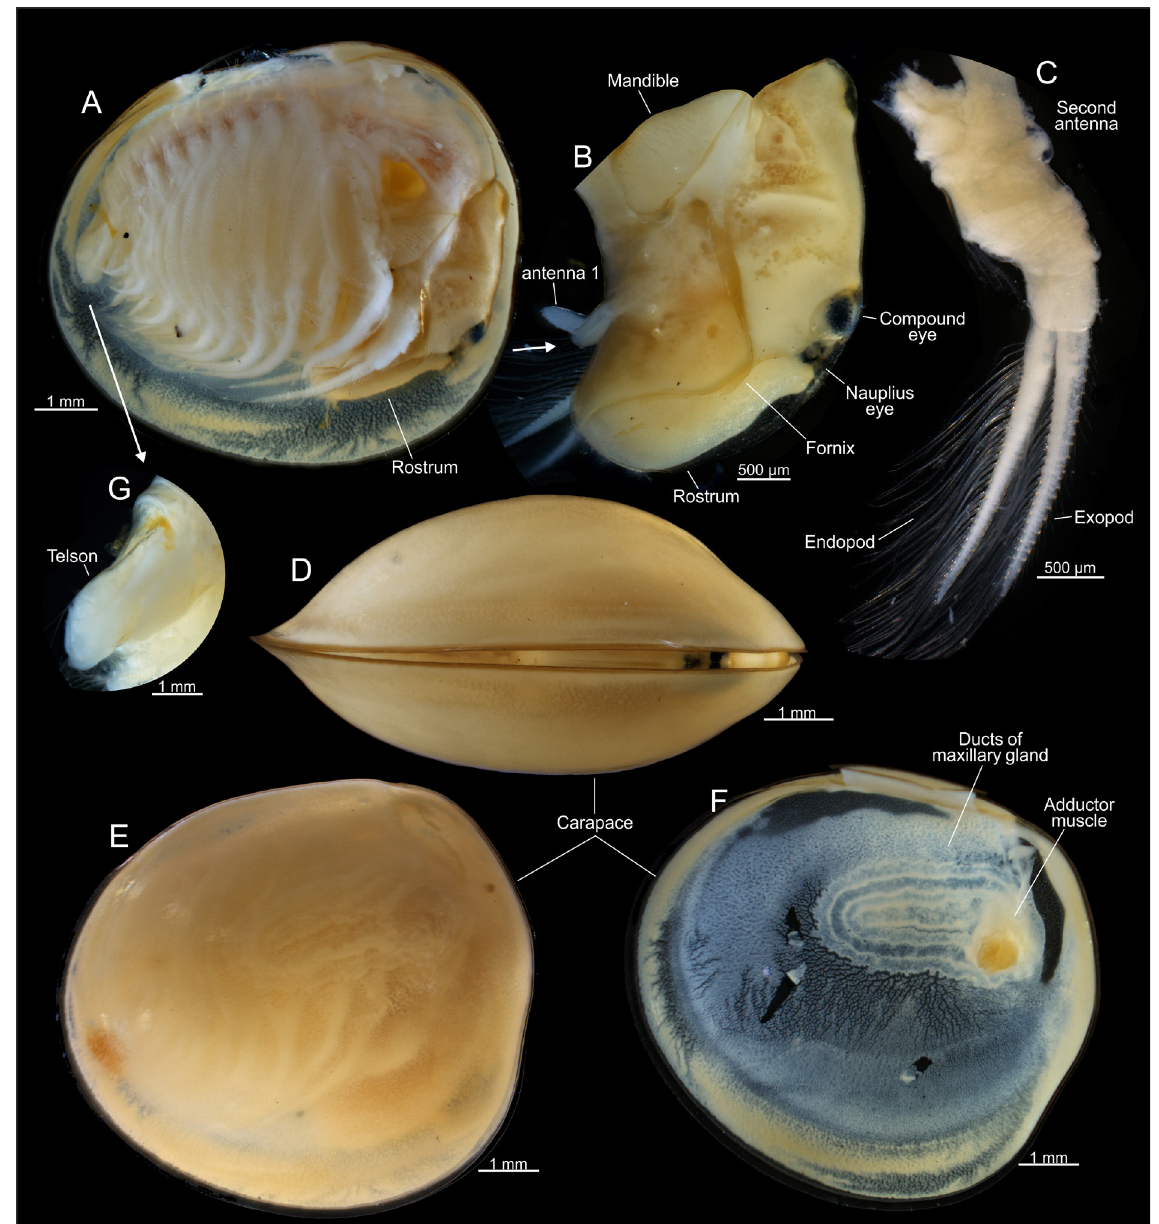
Fig. 2. Lynceus insularis sp. nov., ♂, light microscopy (holotype, ZMUC-CRU-4783). A . Right lateral view with carapace valve removed. B . Head. C . Second antenna, right side. D . Carapace from ventral with body inside. E . Carapace, right lateral view. F . Carapace, left side half seen from